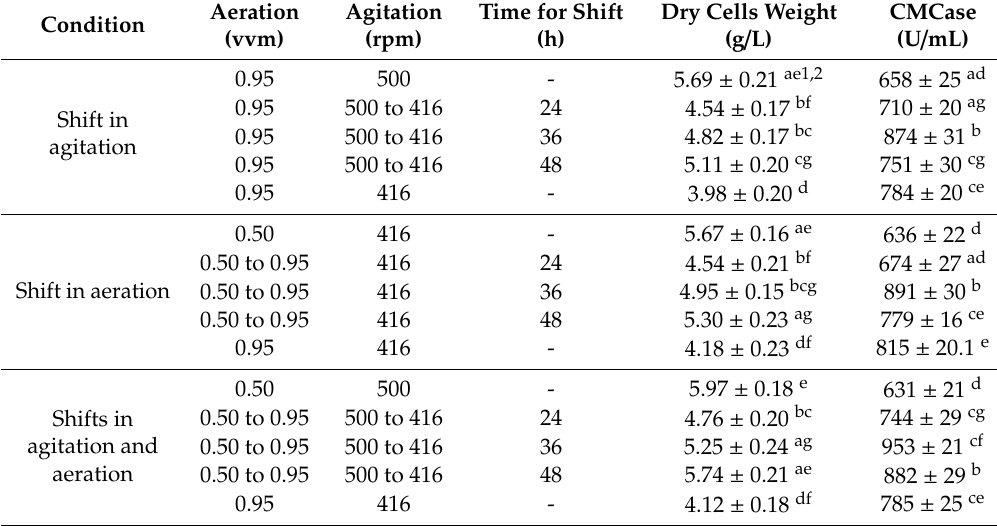
0.50 to 0.95 500 to 416